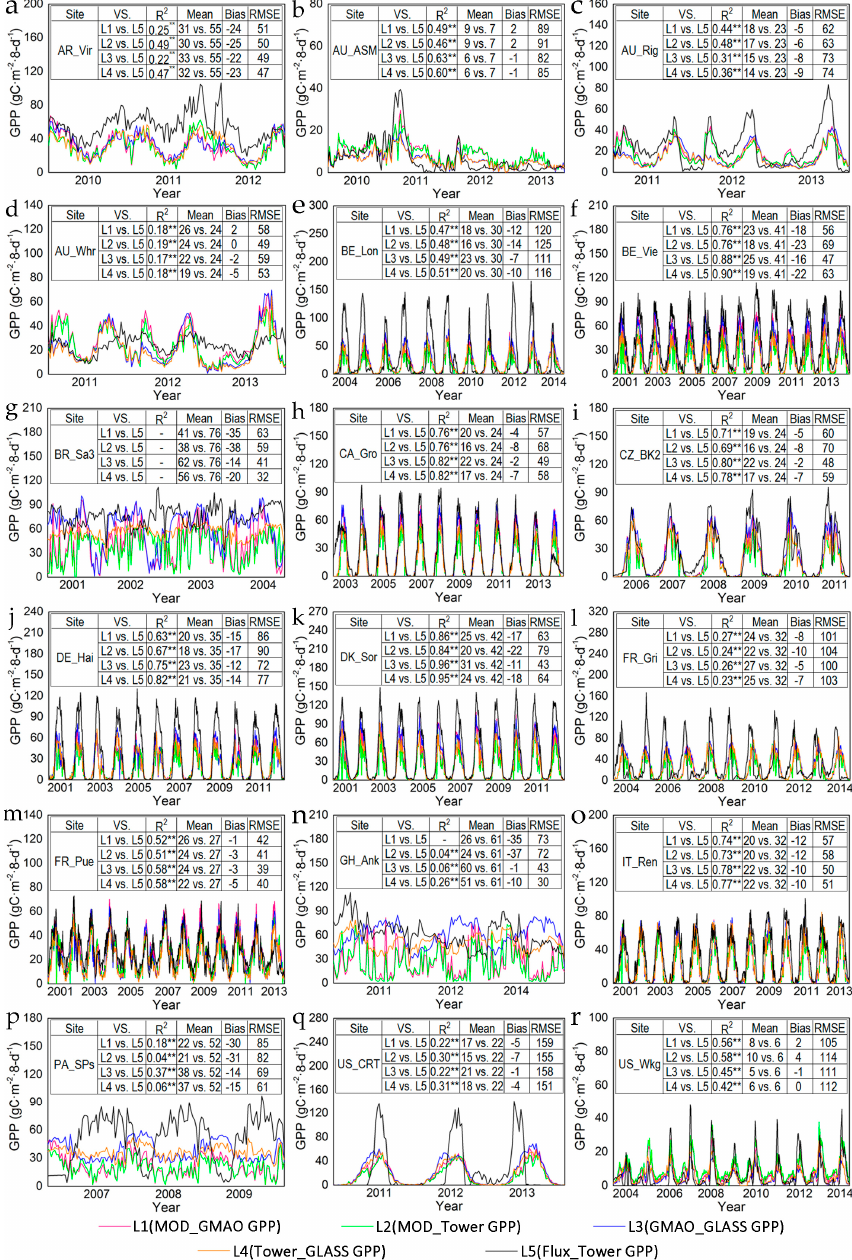
Figure 2. ( a – r ) Time series of eight-day GPP derived from the tower estimates (i.e., Flux_Tower GPP) and four different experimental groups (i.e., MOD_GMAO GPP, MOD_Tower GPP, GMAO_GLASS GPP and Tower_GLASS GPP) at all eighteen sites. The full name for each site is listed in Table 1. The units of the mean and bias are gC·m − 2 ·8-d − 1 , and the RMSE is expressed as a percentage. Significance levels: ** p < 0.01.